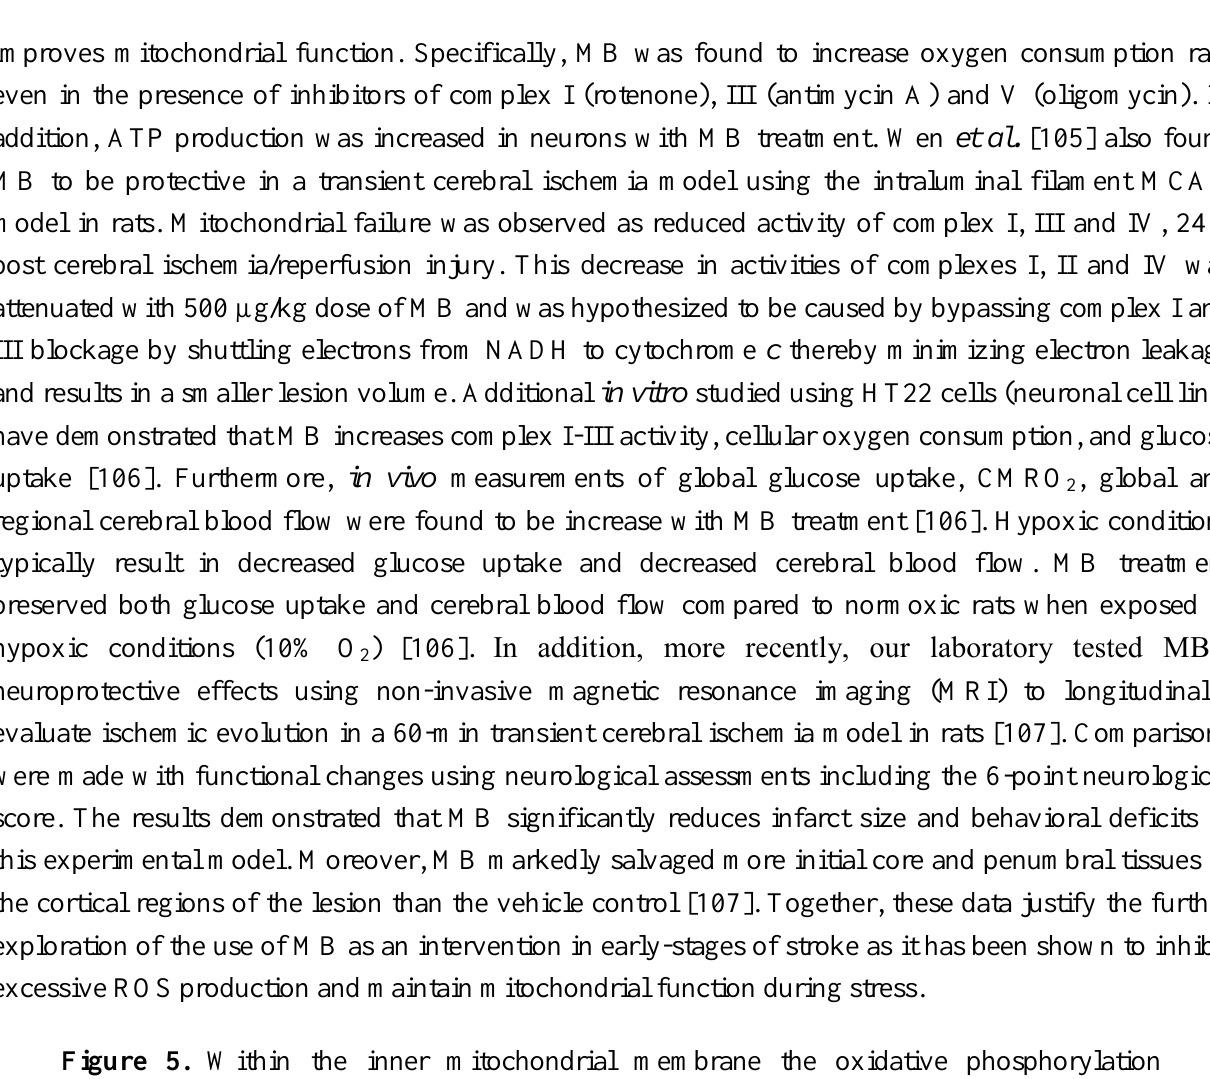
Figure 5. Within the inner mitochondrial membrane the oxidative